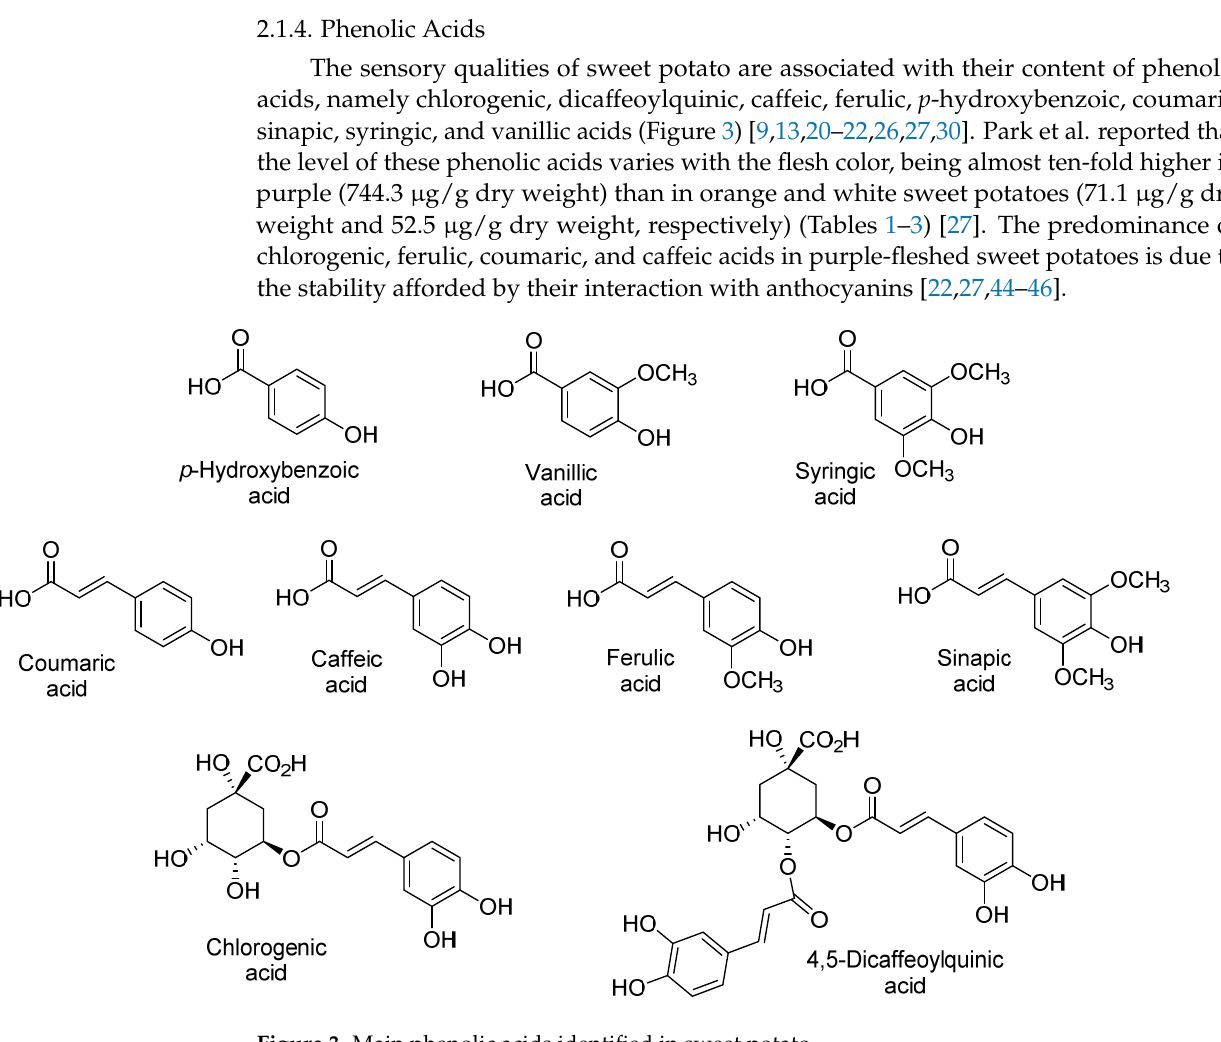
Figure 2. Main anthocyanins in purple sweet potato.